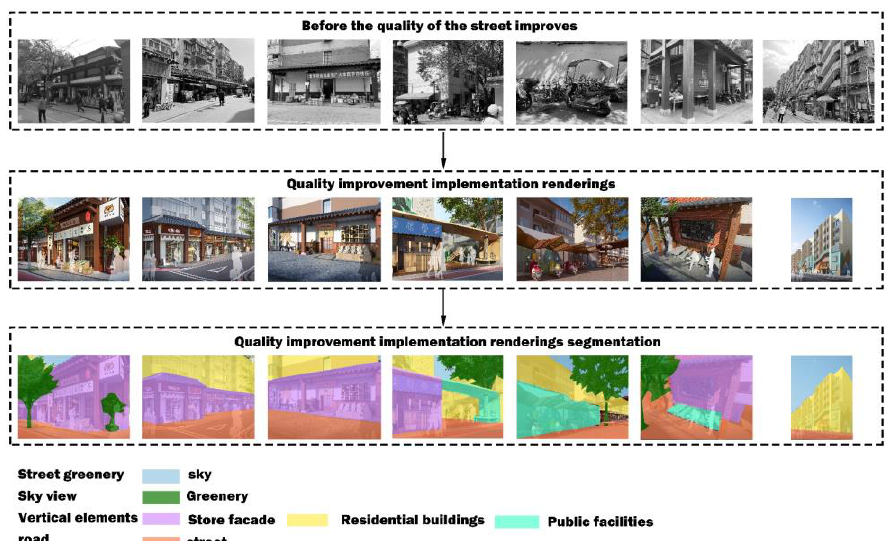
Figure 1. Location analysis map.